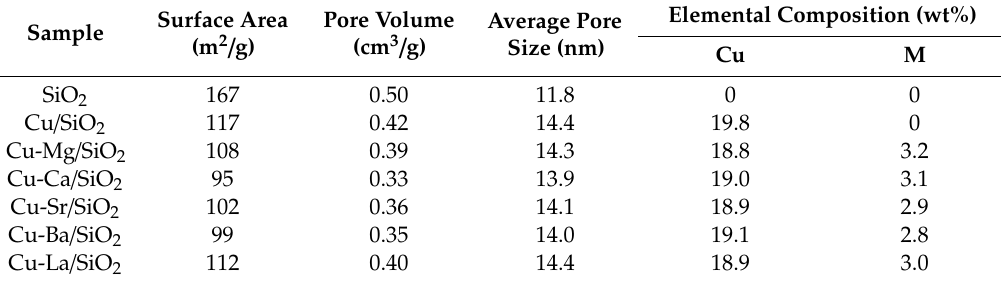
Table 1. Physical properties of the SiO 2 support and Cu-M/SiO 2 catalysts.